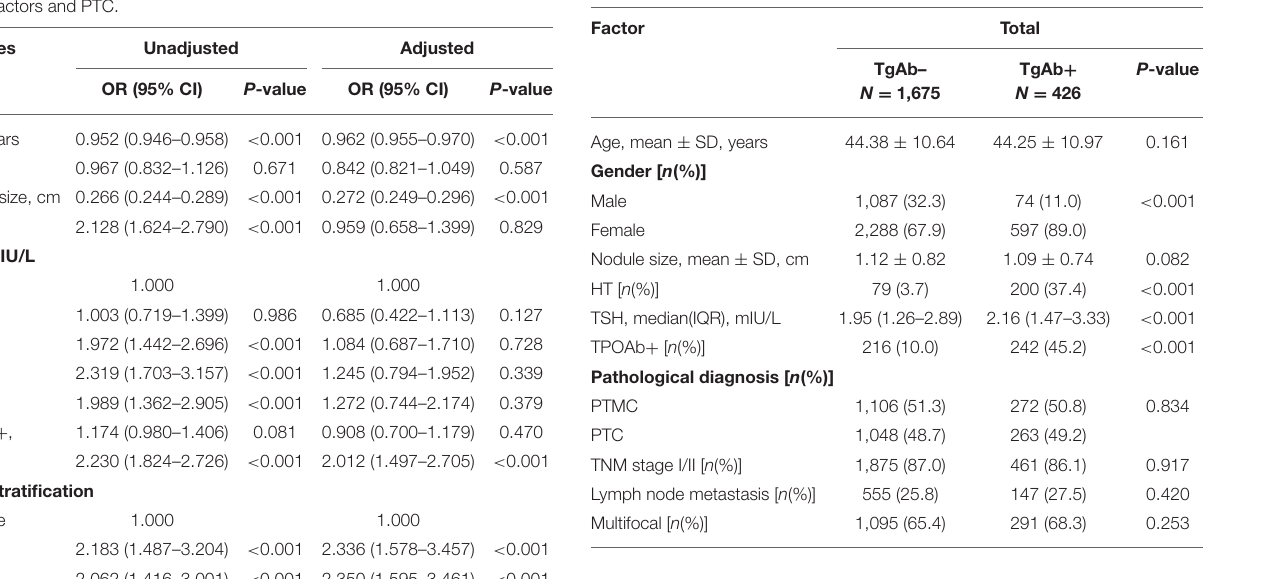
TABLE 5 | Clinical features of TgAb-negative and -positive patients with